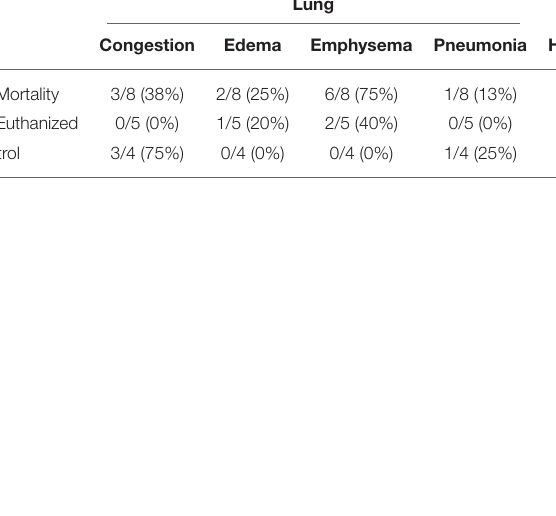
TABLE 2 | Microscopic findings in each group of rabbits and